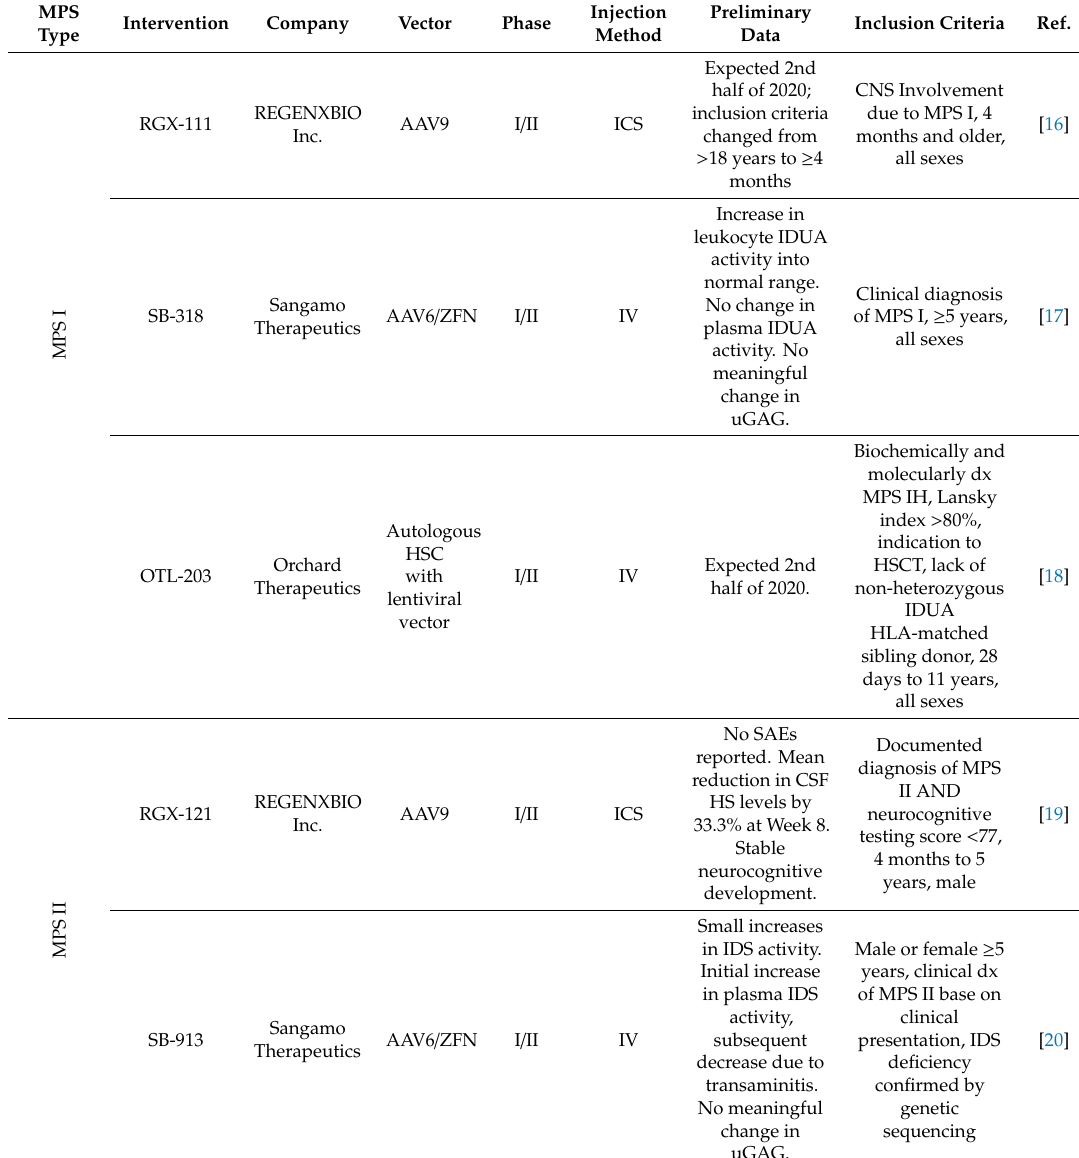
Table 1. Current gene therapy clinical trials for mucopolysaccharidoses (MPS)